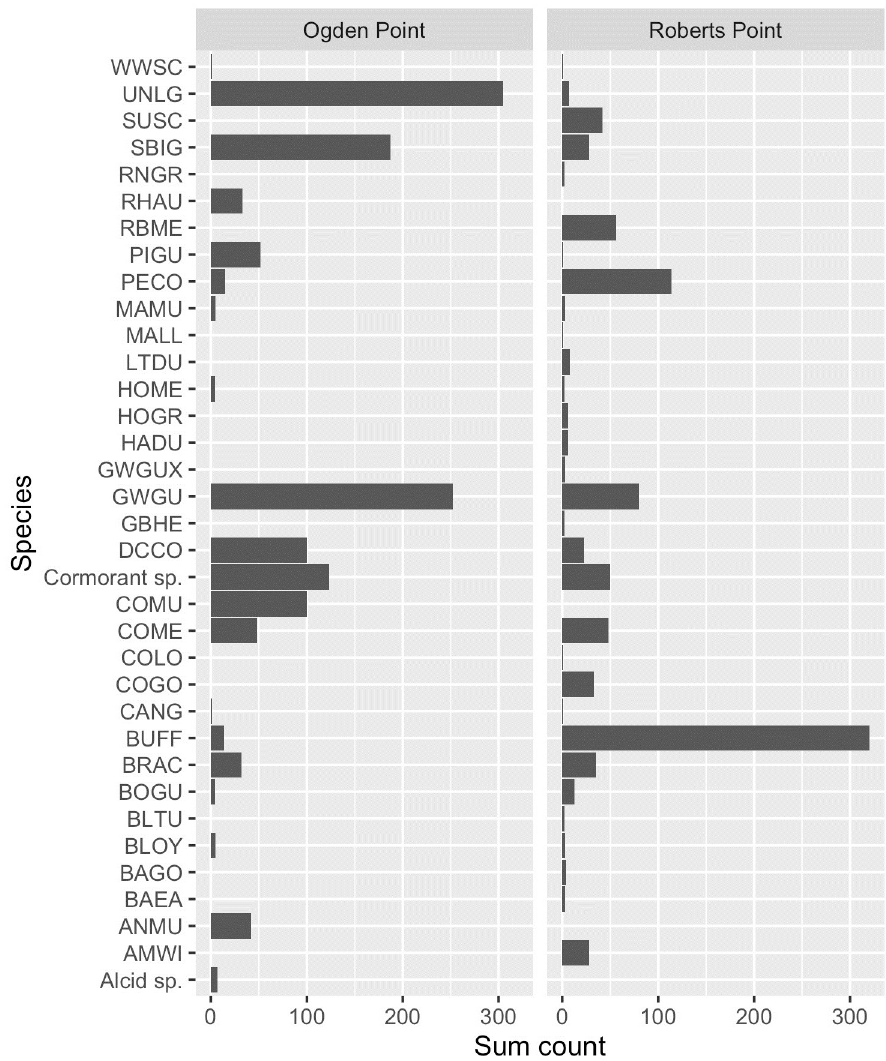
Fig 6. Total counts of waterbird species recorded on hourly 3-minute surveys over 12 survey days, December 2020 to February 2021, Ogden Point (VHMBS) and Roberts Point (SHMBS), Greater Victoria, Canada. Abbreviations are standardized 4-letter alpha codes: AMWI = American Wigeon ( Mareca americana ); ANMU = Ancient Murrelet ( Synthliboramphus antiquus ); BAEA = Bald Eagle ( Haliaeetus leucocephalus ); BAGO = Barrow’s Goldeneye ( Bucephala islandica ); BLOY = Black Oystercatcher ( Haematopus bachmani ); BLTU = Black Turnstone ( Arenaria melanocephala ); BOGU = Bonaparte’s Gull ( Chroicocephalus philadelphia ); BRAC = Brandt’s Cormorant ( Urile penicillatus ); BUFF = Bufflehead ( Bucephala albeola ); CANG = Canada Goose ( Branta canadensis ); COGO = Common Goldeneye ( Bucephala clangula ); COLO = Common Loon ( Gavia immer ); COME = Common Merganser ( Mergus merganser ); Cormorant sp. = Cormorant species (Phalacrocoracidae); DCCO = Double-crested Cormorant ( Nannopterum auritum ); GBHE = Great Blue Heron ( Ardea herodias ); GWGU = Glaucous-winged Gull ( Larus glaucescens ); GWGUX = Glaucous-winged Gull hybrid; HADU = Harlequin Duck ( Histrionicus histrionicus ); HOGR = Horned Grebe ( Podiceps auritus ); HOME = Hooded Merganser ( Lophodytes cucullatus ); LTDU = Long- tailed Duck ( Clangula hyemalis ); MALL = Mallard ( Anas platyrhnychos ); MAMU = Marbled Murrelet ( Brachyramphus marmoratus ); PECO = Pelagic Cormorant ( Urile pelagicus ); PIGU = Pigeon Guillemot ( Cepphus columba ); RBME = Red-breasted Merganser ( Mergus serrator ); RHAU = Rhinoceros Auklet ( Cerorhinca monocerata ); RNGR = Red-necked Grebe ( Podiceps grisegena ); SBIG = Short-billed Gull ( Larus brachyrhynchus ); SUSC = Surf Scoter ( Melanitta perspicillata ); UNLG = Unidentified Larus gull; WWSC = White-winged Scoter ( Melanitta deglandi